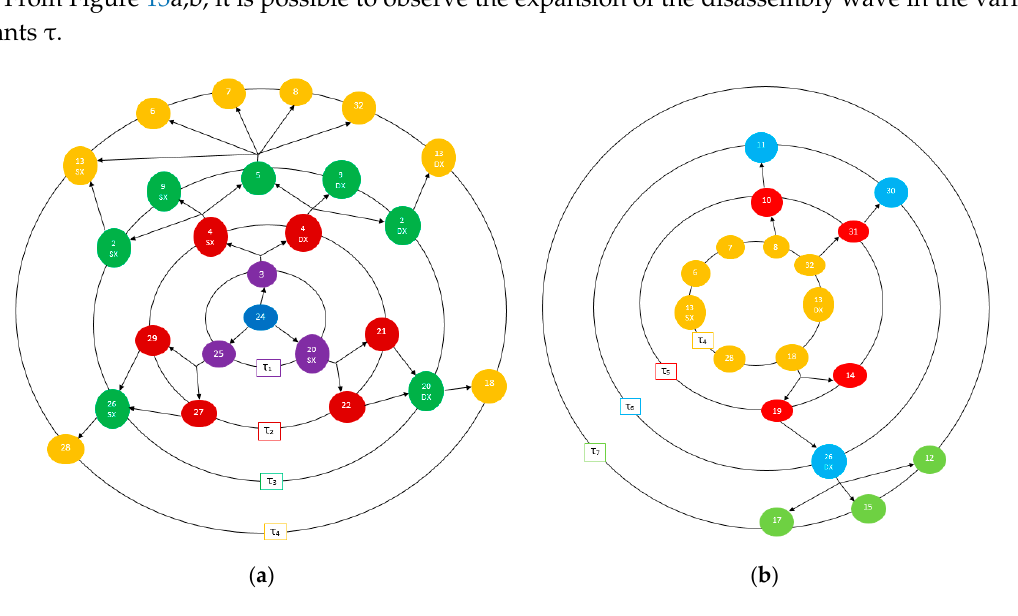
Figure 12. Exploded view.